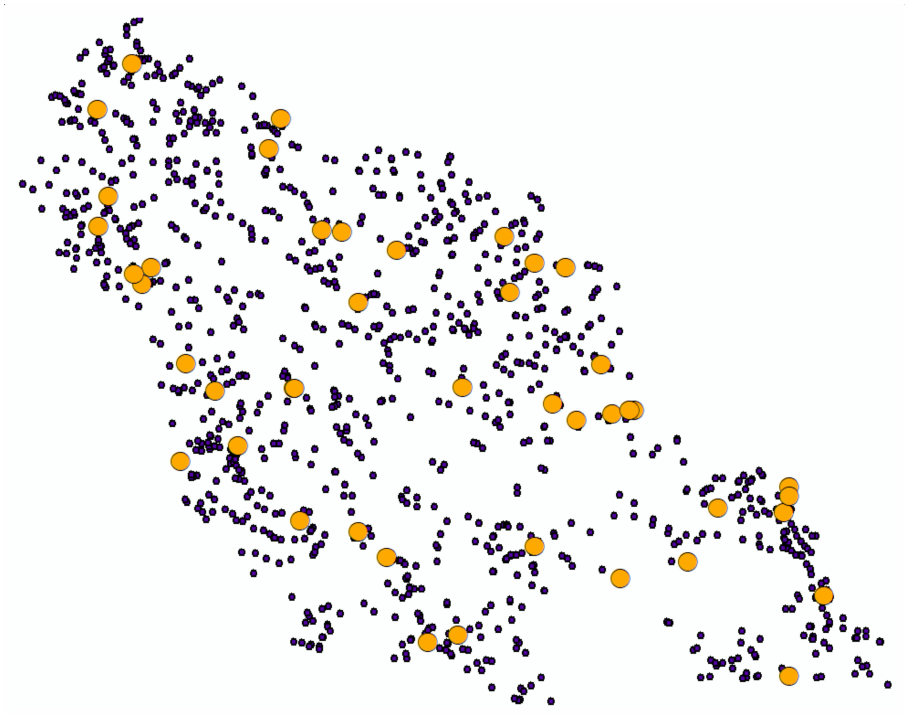
Figure 7. Real sensor data